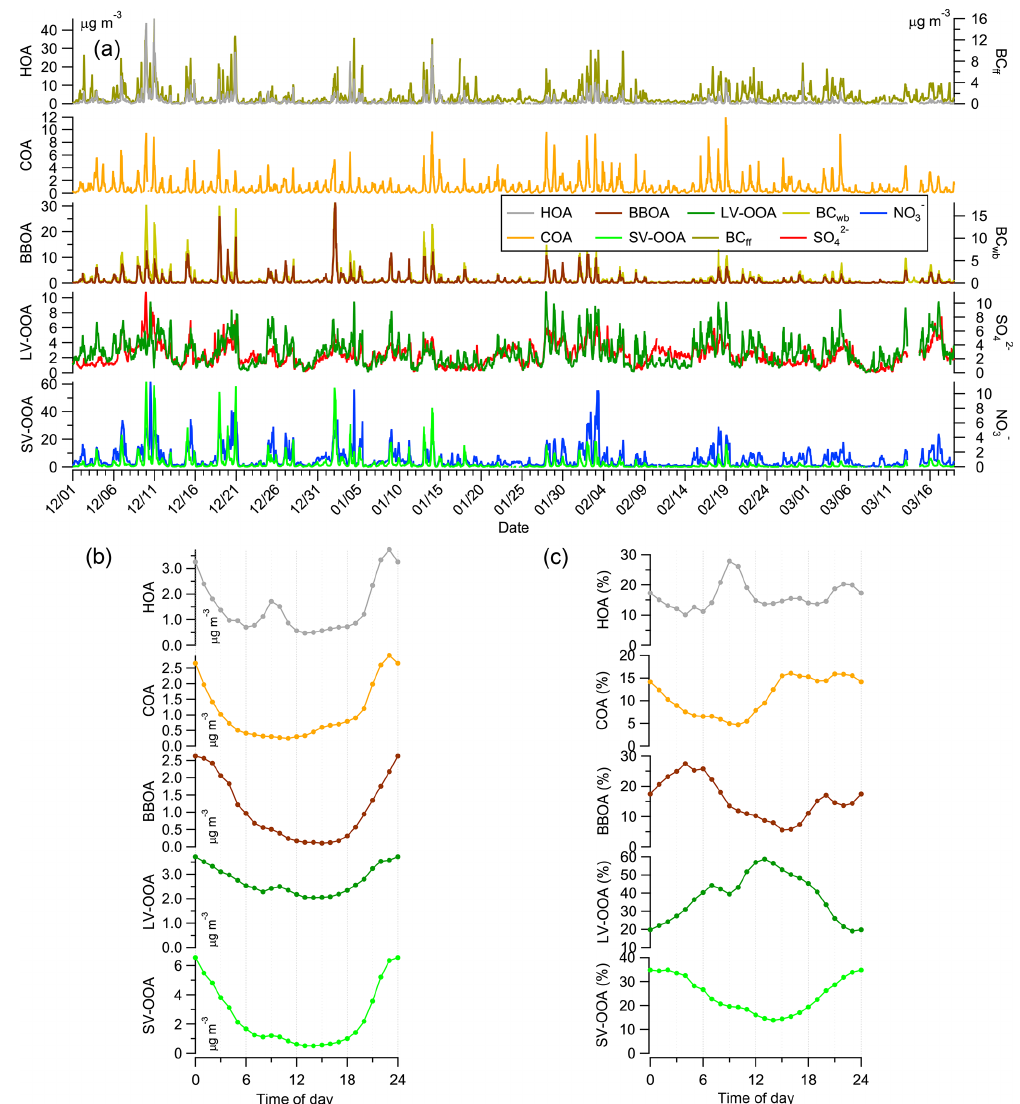
Figure 6. Time series of the contribution of the different factors identified by PMF between 21 November 2016 and 1 March 2017 (a) along with their average diurnal cycle (b) and respective hourly contribution (c)